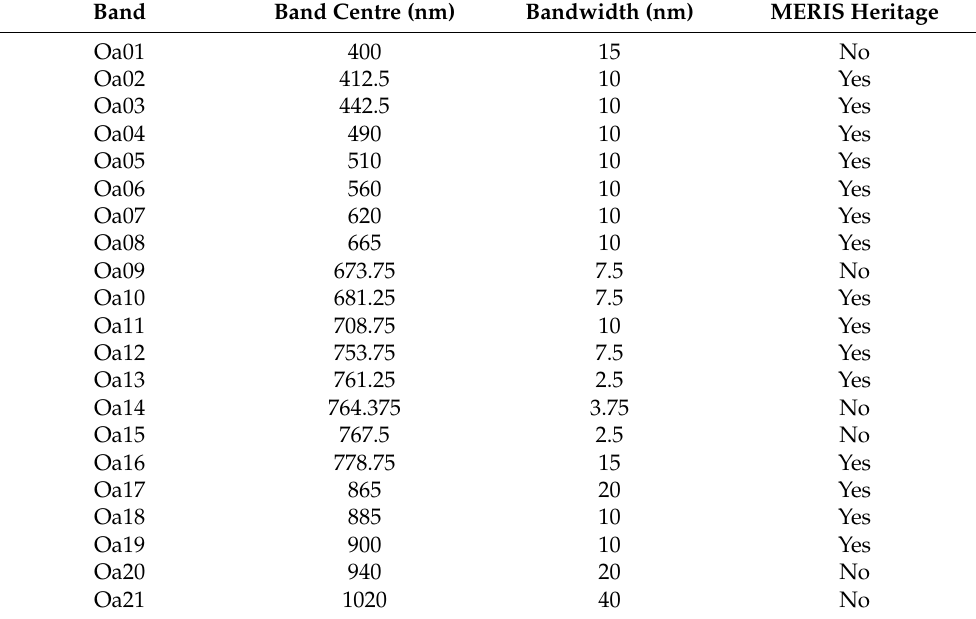
Table 1. OLCI bands characteristics. The band indicated in grey was the one used as input for the C3SBA10